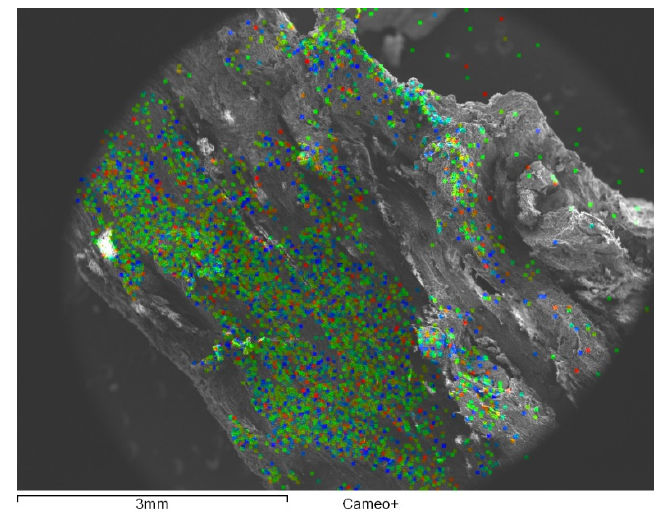
Figure 10. SEM-EDX image showed the penetrations of MH NPs inside the sample, following the Mg mapping.